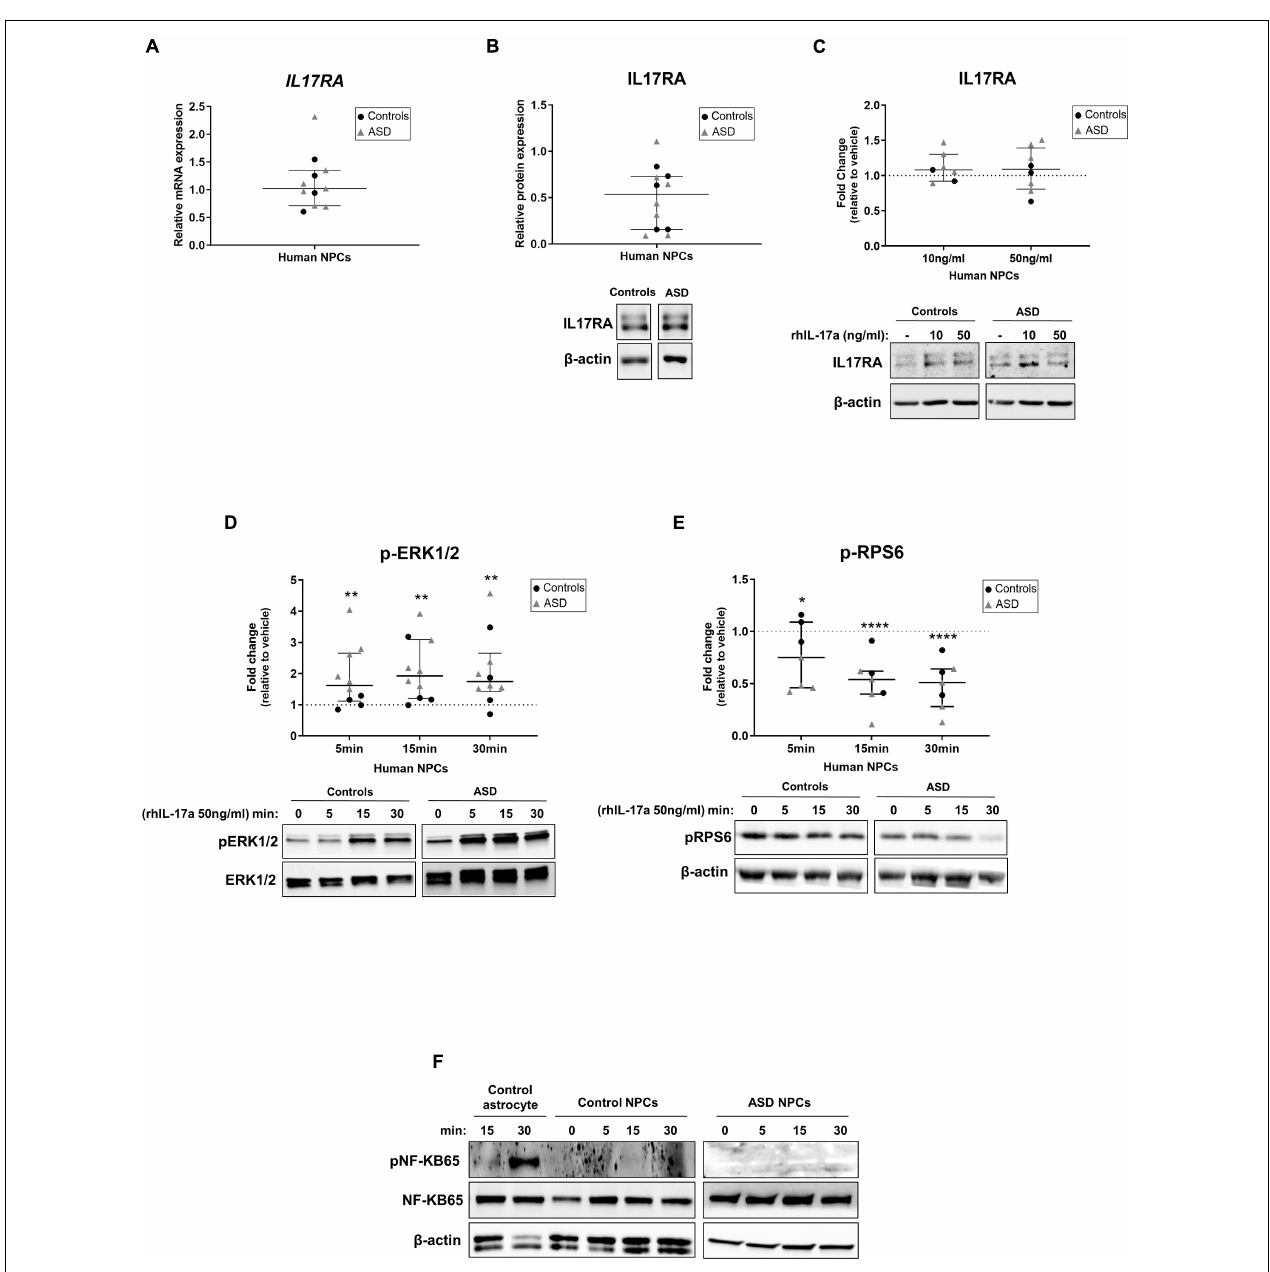
FIGURE 1 | Human NPCs express IL17RA and respond to exogenous IL-17a by modulating the activity of ERK1/2 and mTORC1 signaling pathways. (A) Relative transcript levels of IL17RA in iPSC-derived NPCs of control ( n = 4) and ASD ( n = 7) subjects. (B) Relative protein levels of IL17RA in iPSC-derived NPCs of control ( n = 5) and ASD ( n = 7) subjects. β -actin was used as a loading control and representative immunoblot images are shown. Human NPCs endogenously express IL17RA. (C) Relative protein levels of IL17RA in iPSC-derived NPCs of control ( n = 2–3) and ASD ( n = 5) subjects after treatment with either vehicle (–) or rhIL-17a (10 and 50 ng/ml) for 48 h. The data are expressed as fold change in IL17RA expression relative to vehicle-treated samples. β -actin was used as a loading control and representative immunoblot images are shown. No significant differences in the protein levels of IL17RA were observed between rhIL-17a-treated and untreated human NPCs. (D) Time course analysis of pERK1/2 expression in iPSC-derived NPCs of control ( n = 4) and ASD ( n = 6) subjects after treatment with either vehicle (–) or rhIL-17a (50 ng/ml). Total-ERK was used as a loading control and the data are expressed as fold change in normalized pERK1/2 expression relative to vehicle-treated samples. Representative immunoblot images are shown. (E) Time course analysis of pRPS6 expression in iPSC-derived NPCs of control ( n = 3) and ASD ( n = 4) subjects after treatment with either vehicle (–) or rhIL-17a (50 ng/ml). β -actin was used as a loading control and the data are expressed as fold change in normalized pRPS6 expression relative to vehicle-treated. Representative immunoblot images are shown. Exogenous IL-17a led to a significant increase in pERK1/2 levels and significant decrease in pRPS6 levels in human NPCs. * p ≤ 0.05, ** p ≤ 0.01, and **** p ≤ 0.0001. (F) Time course analysis of pNF-kB65 expression in iPSC-derived astrocytes (used as positive control of pNF-kB expression) and in iPSC-derived NPCs of control ( n = 2) and ASD ( n = 1) subjects after treatment with either vehicle (–) or rhIL-17a (50 ng/ml). Total-NF-kB and β -actin were used as a loading controls and representative immunoblot images are shown. While iPSC-derived astrocytes express pNF-kB65, no detectable expression of this protein was observed in human NPCs.